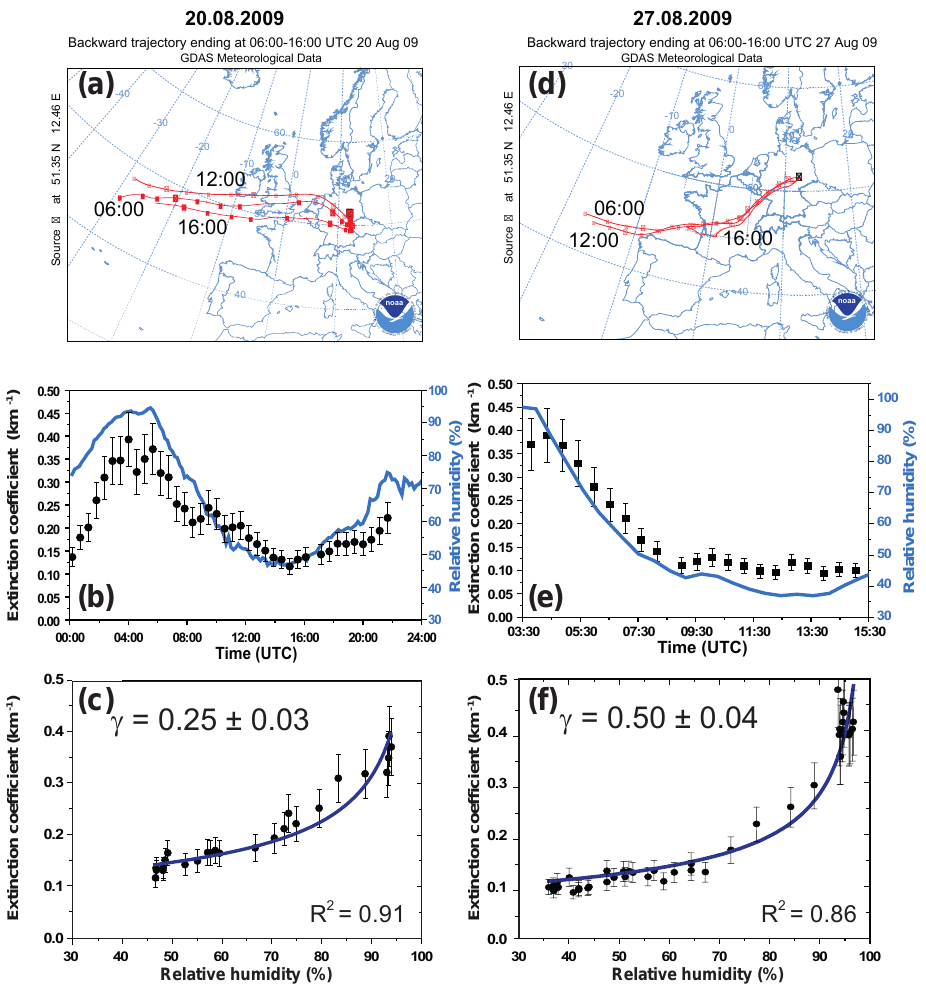
Figure 5. SÆMS observations on (left) 20 August 2009 and (right) 27 August 2009. Almost constant horizontal transport of polluted air from westerly to southwesterly directions is indicated by 4-day HYSPLIT backward trajectories ( a , d , arrival height of 500m). The temporal variation of the 550nm particle extinction coefficient with relative humidity is shown in (b) for 20 August 2009 and in (e) for 27 August 2009, and the corresponding relationship between ambient extinction coefficient and relative humidity is presented in (c, f) . The curves fitted to the data points in (c, f) are obtained with Eq. (3). The coefficient of determination R 2 for each fit is given as